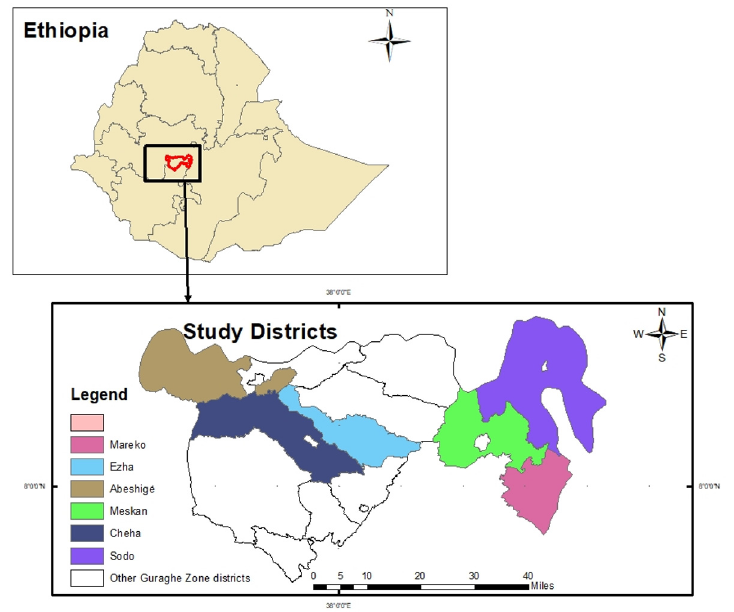
Figure 1. Location map of